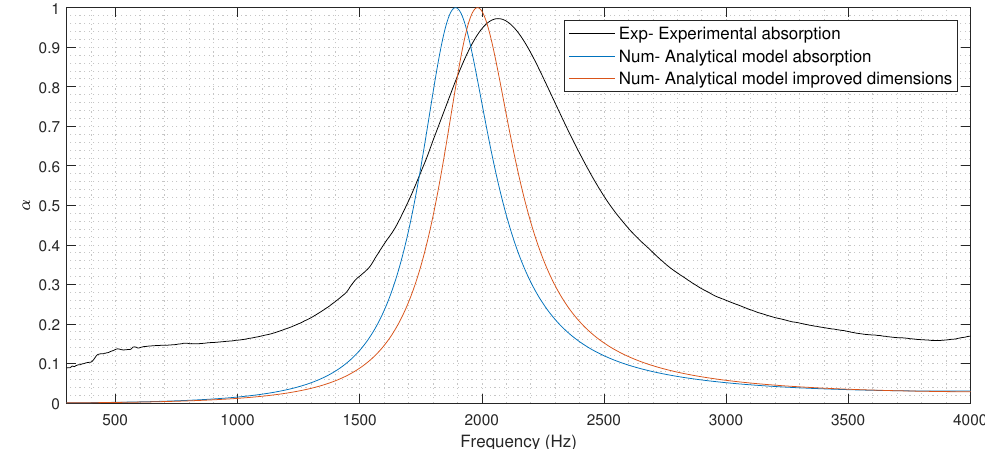
Figure 6. Normal incidence absorption results